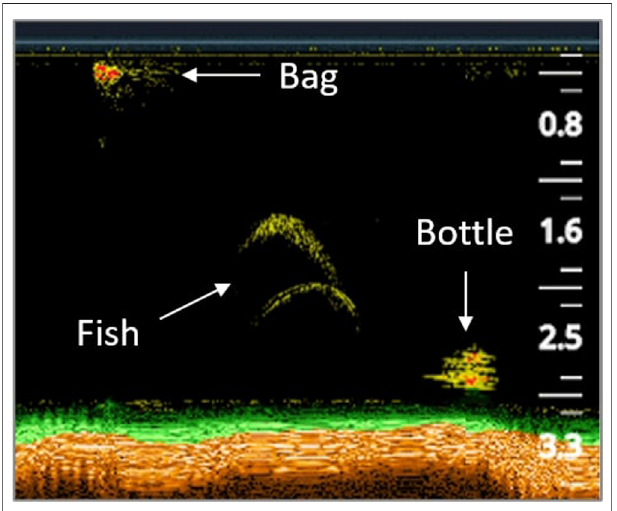
FIGURE1| Sonarimageexampleincludingaplasticbag,bottleand fi sh. Obtained using the Deeper CHIRP + fi sh fi nder. The numbers on the vertical axis present the depth below the water surface (m).